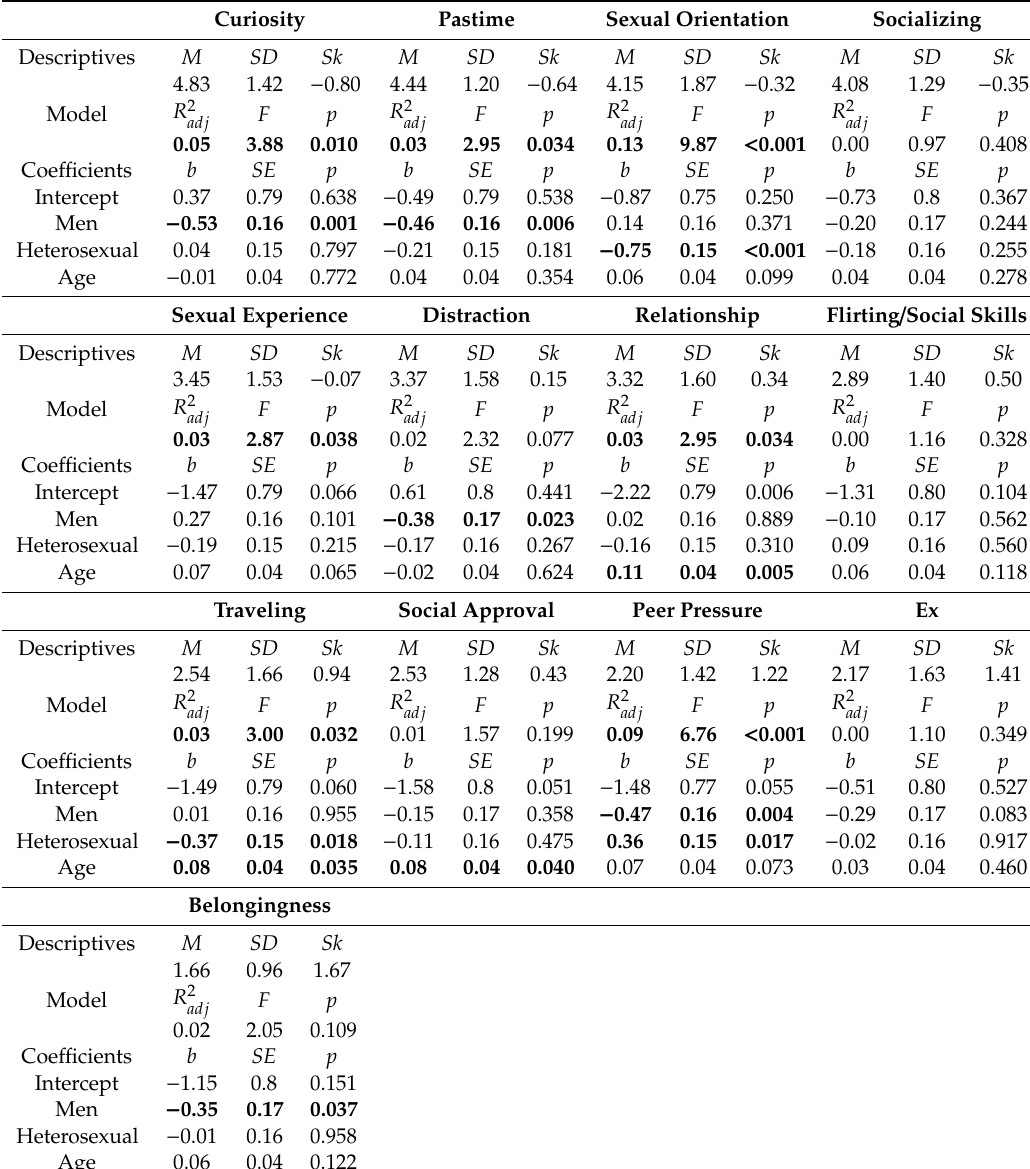
Table 4. Multiple regression analysis of the Tinder motives